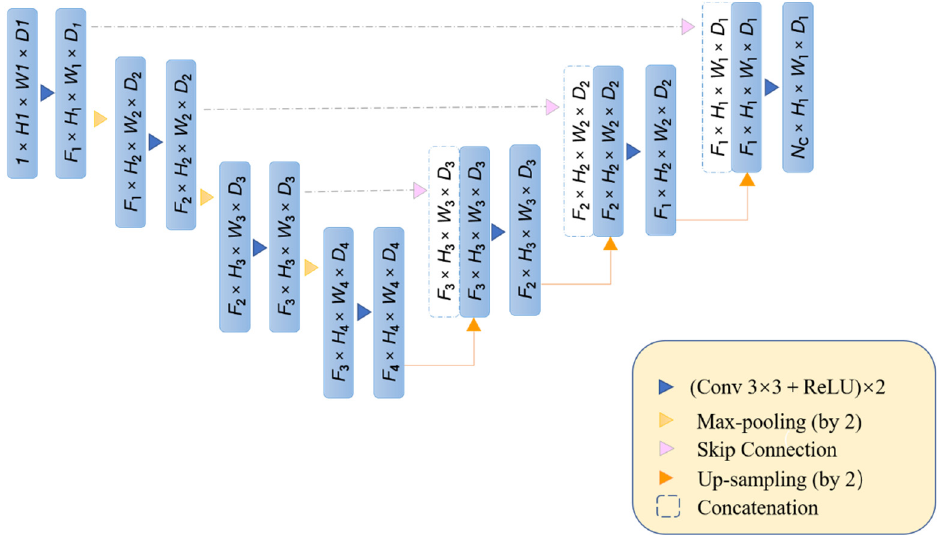
Figure 2. Visualized structure of Unet